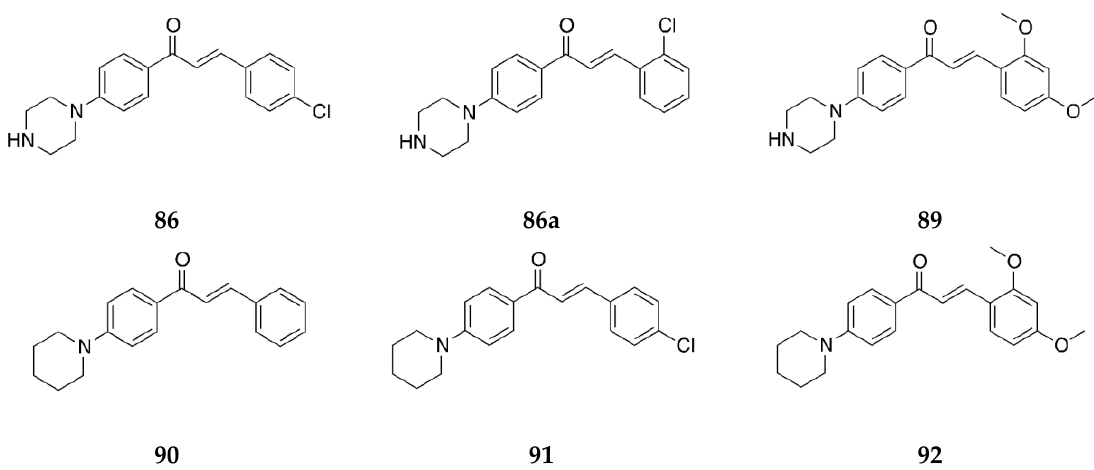
Figure 44. Chemical structures of N,N -dialkylated 4-aminochalcone derivatives.